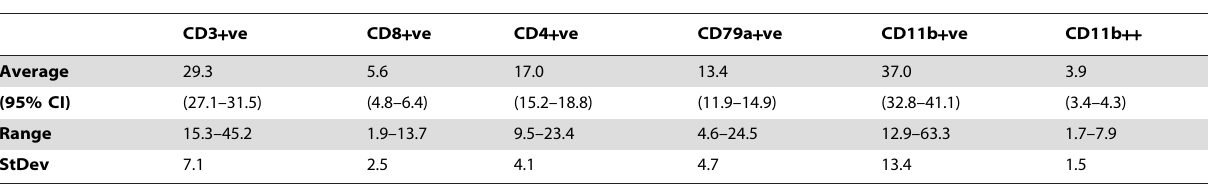
Table 2. Normal cell